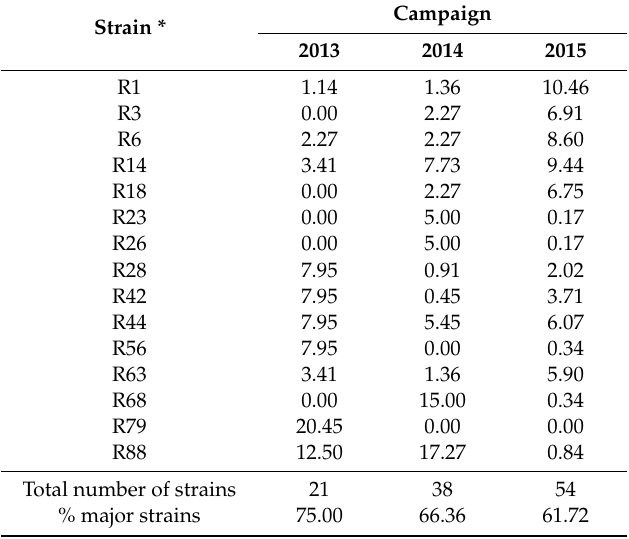
Table 4. Frequency of the main S. cerevisiae strains per campaign.